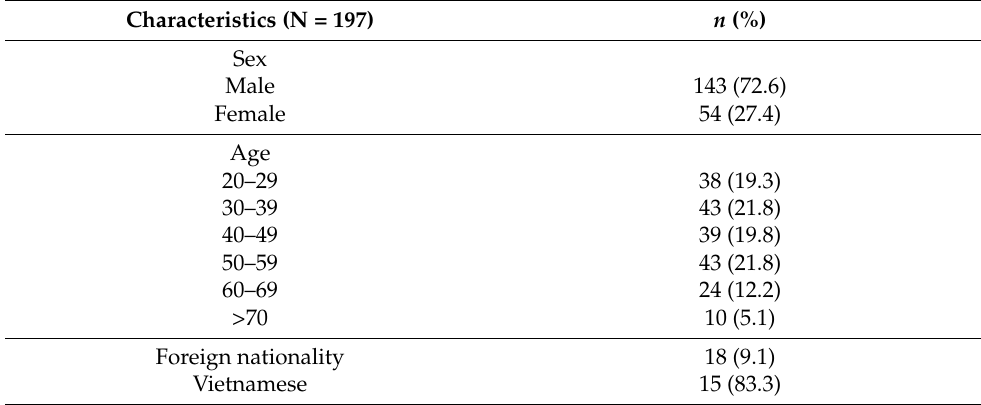
Table 2. Patient demographics and